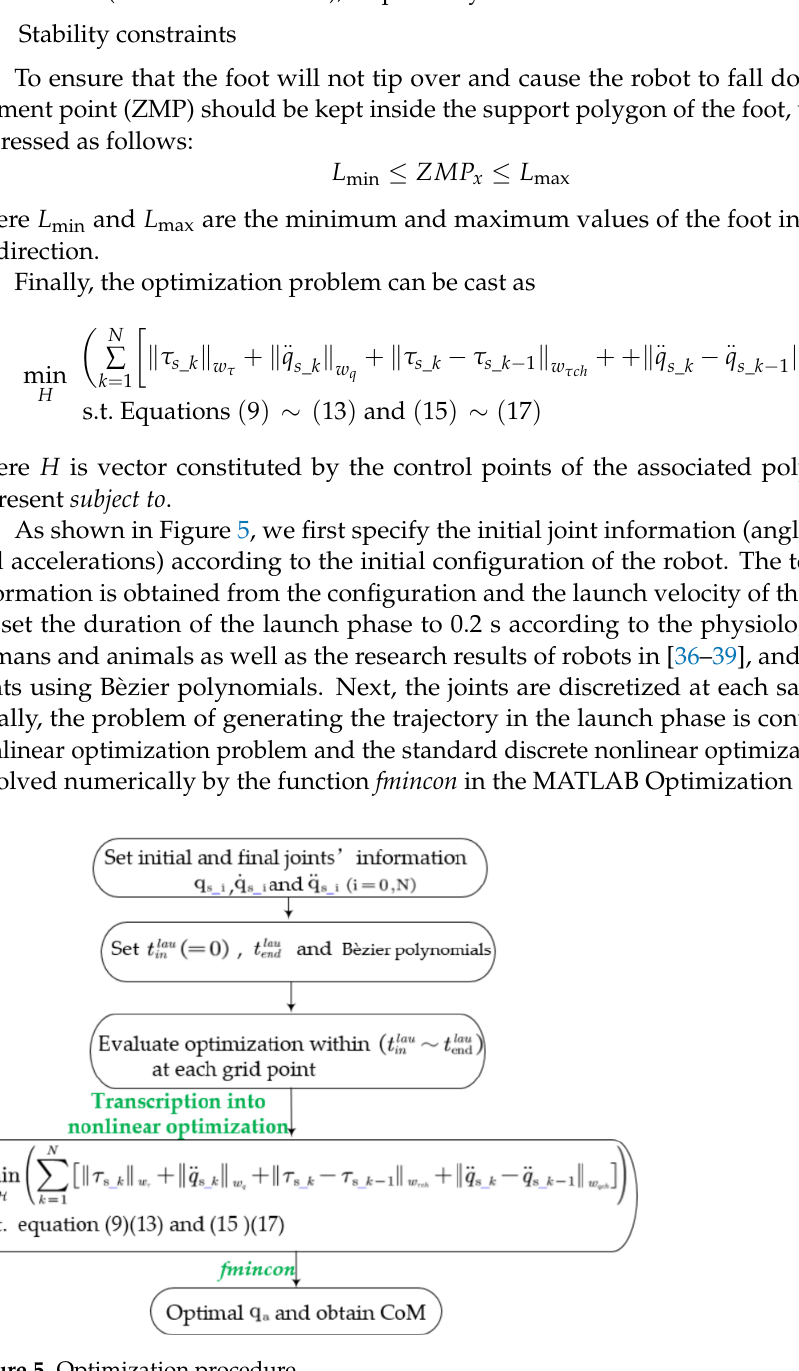
Table 2. Parameter vector and weights in the optimization for trajectory generation.